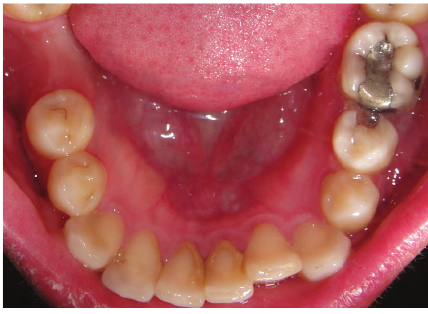
Figure 1: Preoperative intraoral view of the case.